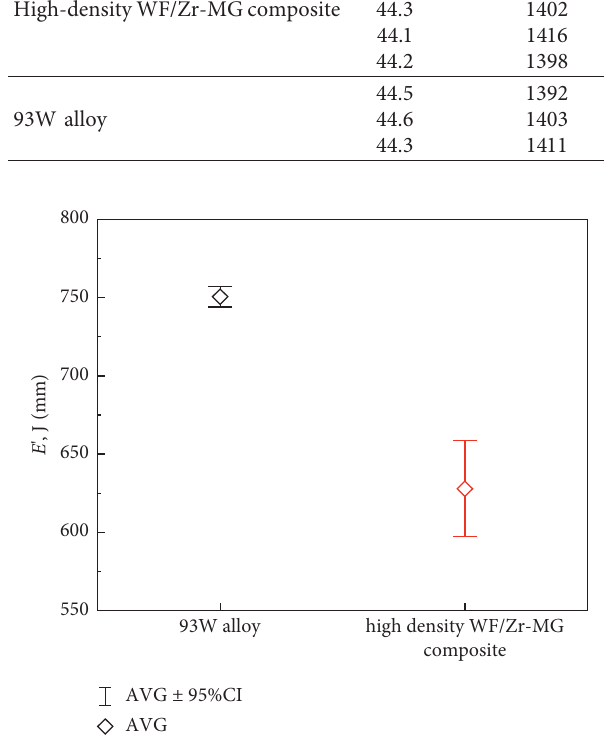
Figure 6: The E ′ of two different material